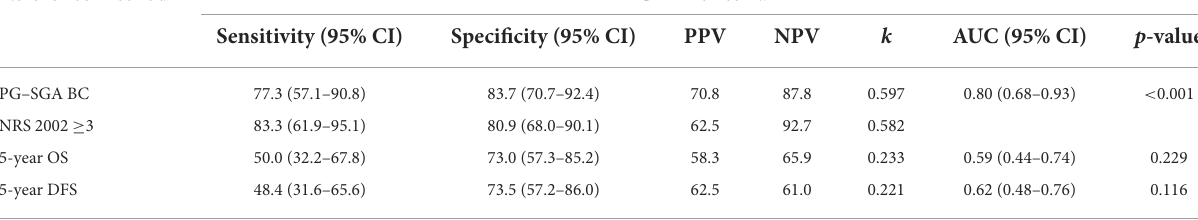
TABLE 3 Diagnostic value of GLIM criteria in predicting malnutrition and